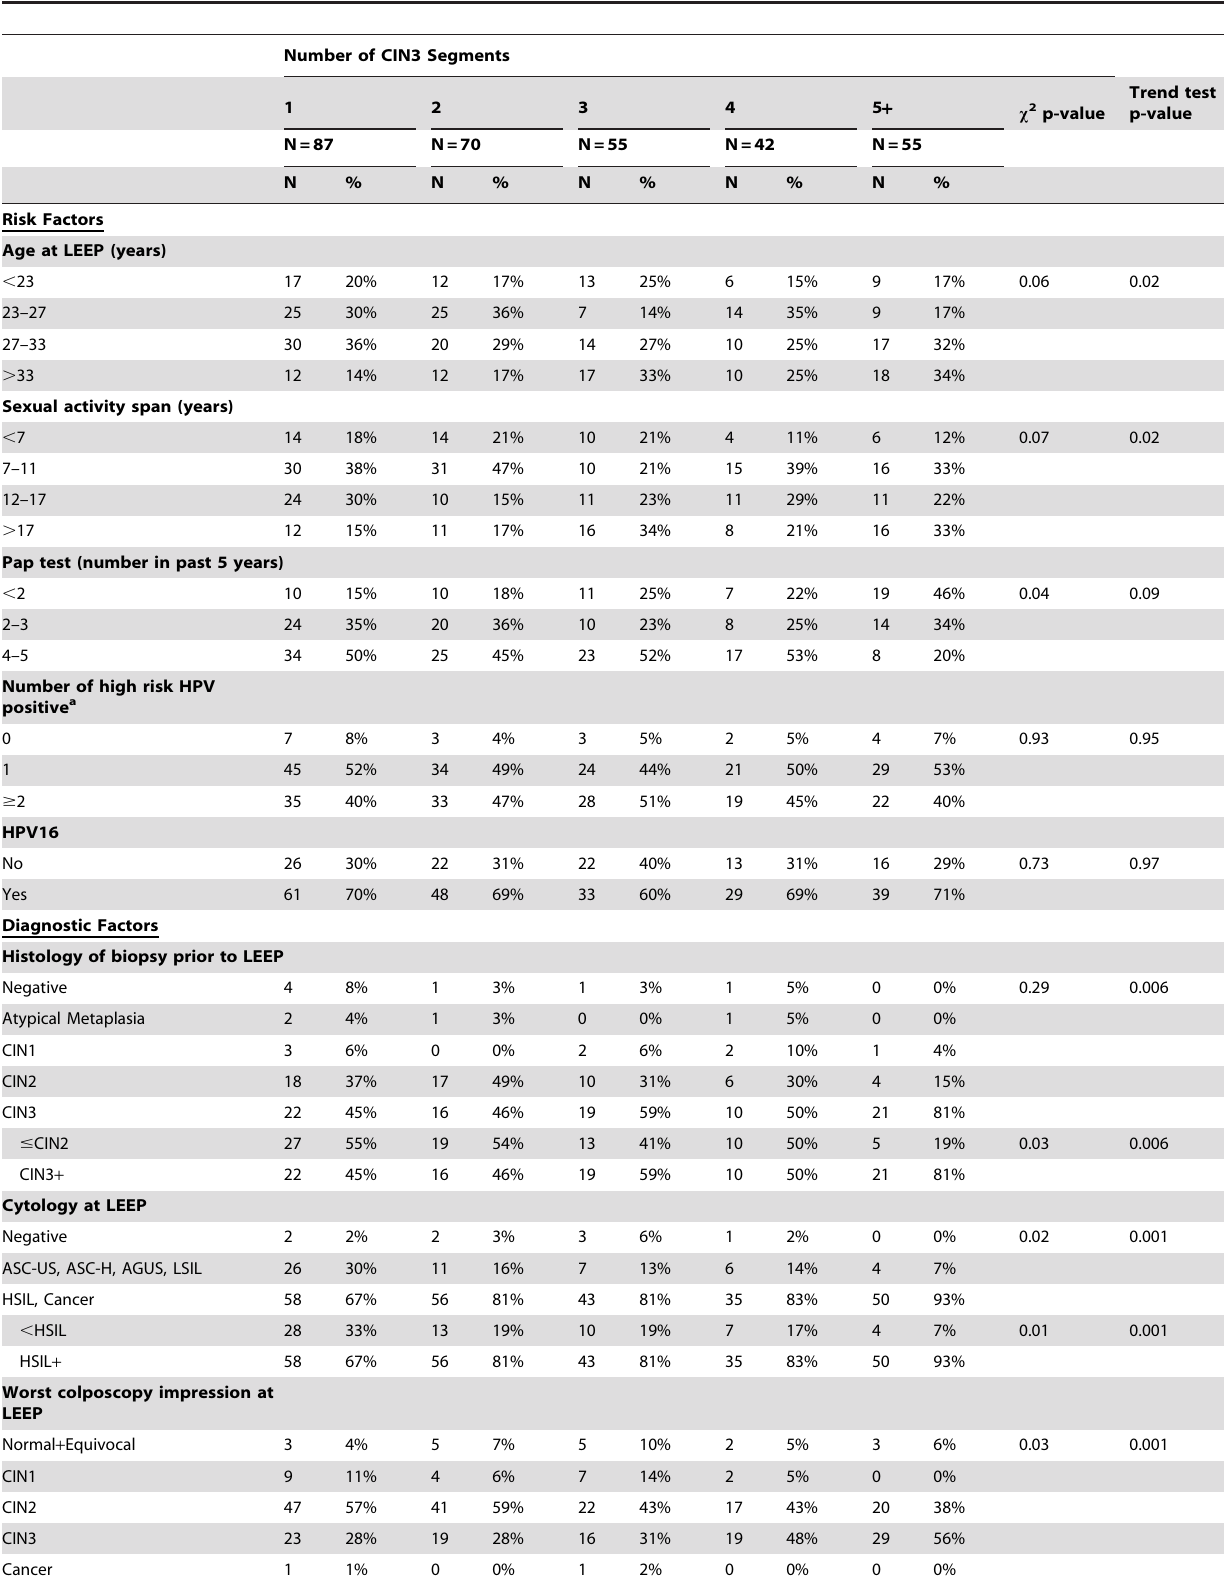
Table 3. Distribution of risk factors and diagnostic factors by CIN3 size among women in SUCCEED diagnosed as CIN3 by LEEP (N=